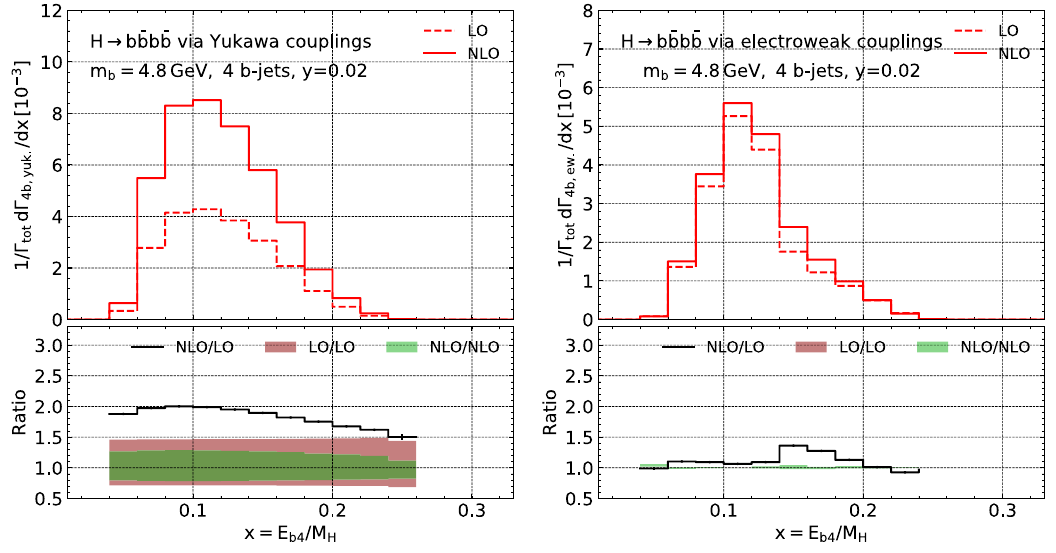
Figure 10 . Similar to figure 7 for distribution as a function of the energy of the softest b